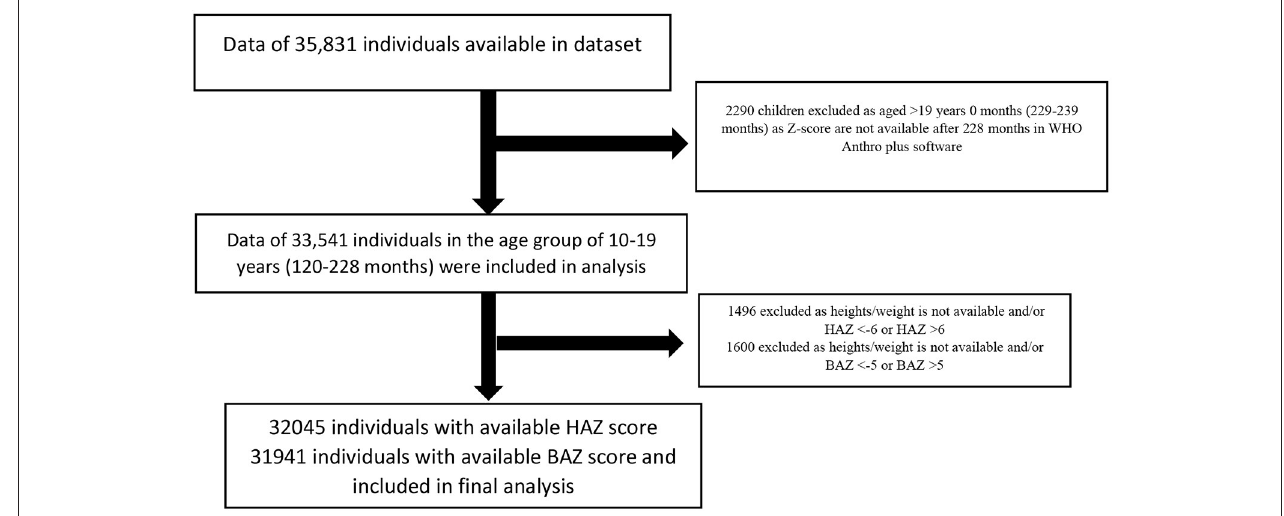
FIGURE 1 | Flow diagram of children aged 10–19 years included in the analysis.